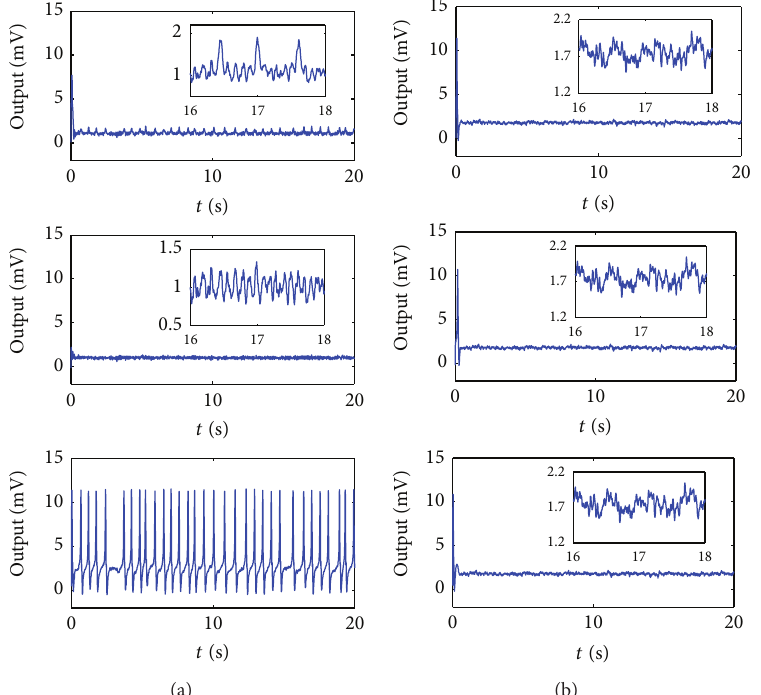
Figure 8: The output waveforms for the use of the proposed control to the model containing three hyperexcitable populations. (a) 𝑘 𝑝1 = = 8 , 𝑘 = 0 . (b) 𝑘 = 𝑘 = 𝑘 = 1.62 . 𝑘 𝑝2 𝑝3 𝑝1 𝑝2 𝑝3